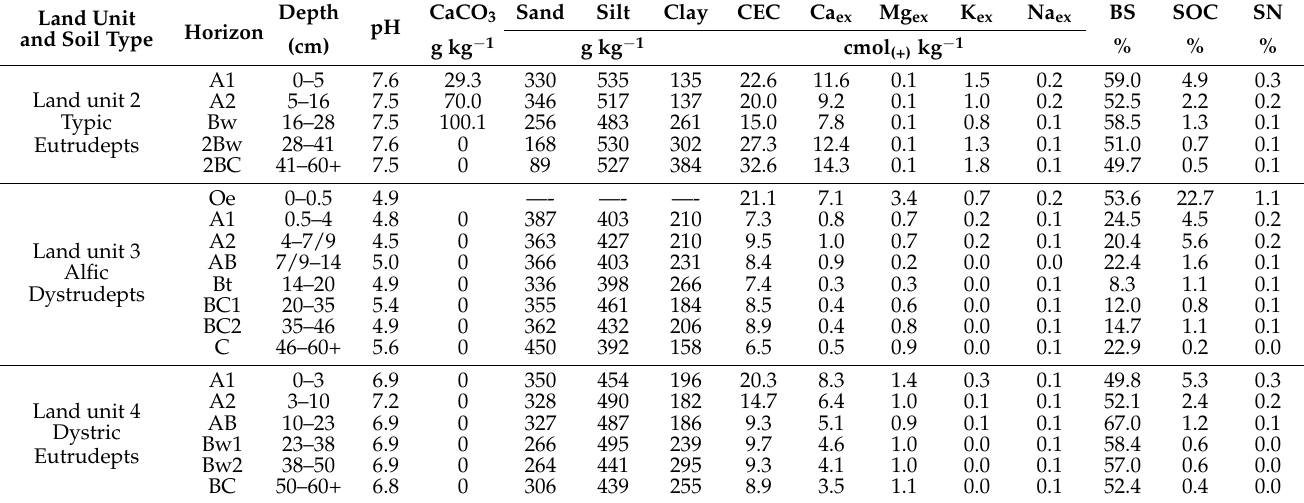
Table 3. Main morphological, physical, and chemical features of soil profiles dug within the land units 2, 3, and 4 of Castel del Rio, Emilia-Romagna Region, Italy.